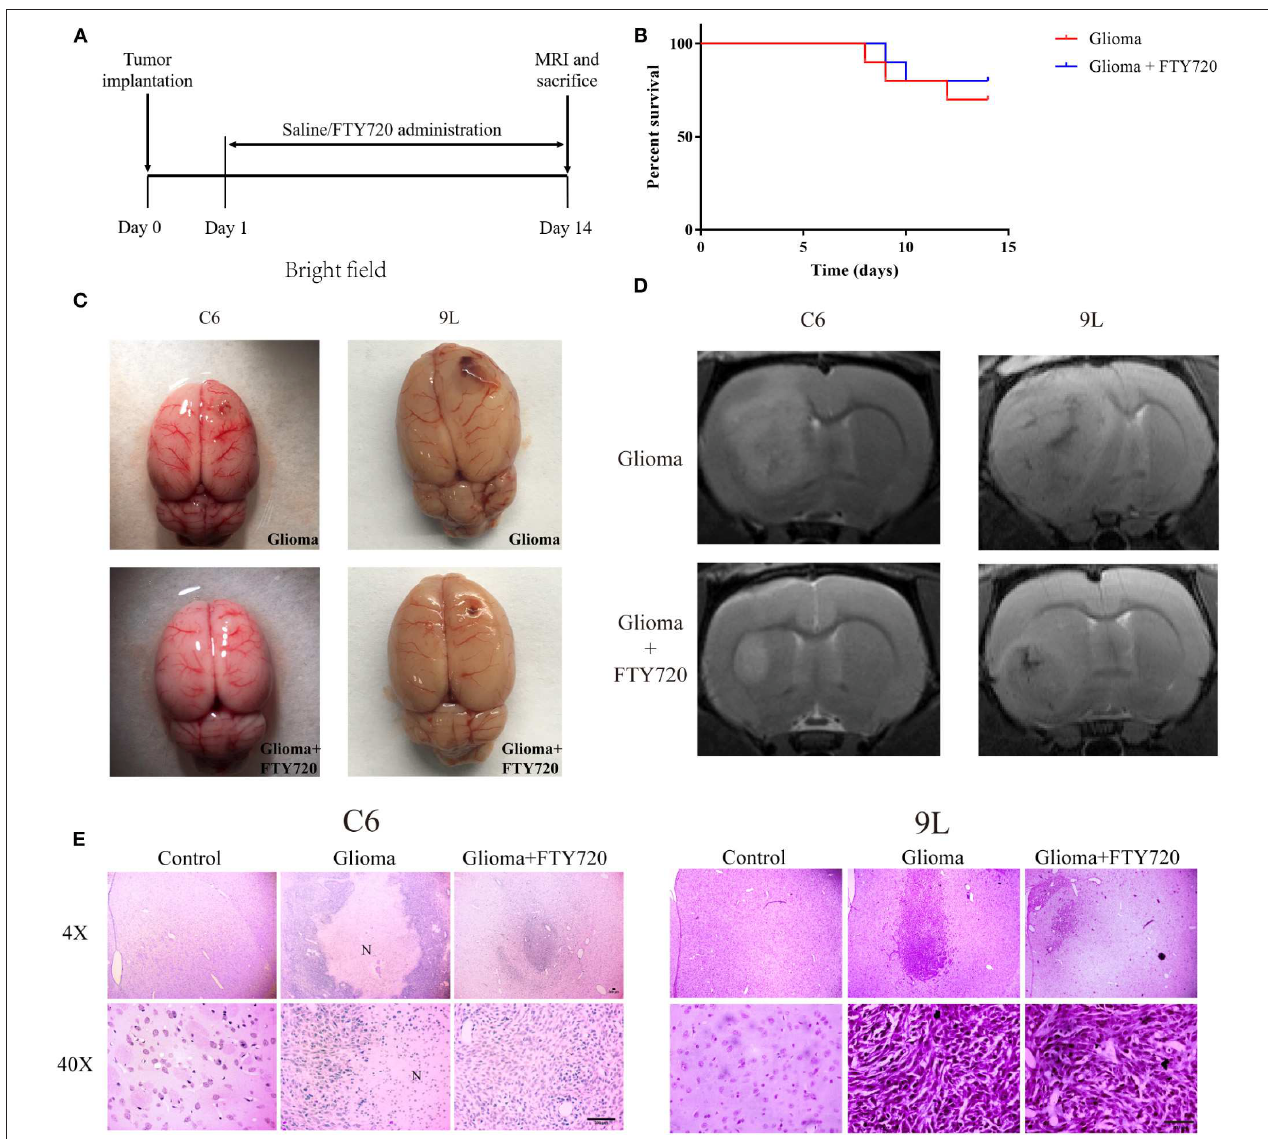
FIGURE 1 | The anti-tumor effects of FTY720 on C6 and 9Lglioma rat models. (A) Experimental progress and treatment of C6 and 9L glioma rat models. (B) Survival differences of glioma rat models treated with saline or FTY720 for 14 days. n = 10 for each group. (C) Development of glioma in C6 and 9L glioma allograft models. (D) Representative MRI analysis of gliomas treated with saline or FTY720 14 days after tumor implantation. (E) Histopathological analysis of tumor distributions in brain sections. Upper and lower panels show lower (4 × ) and higher (40 × ) magnifications, respectively. N, necrotic area. Scale bar, 300 µ m, n = 5–6.